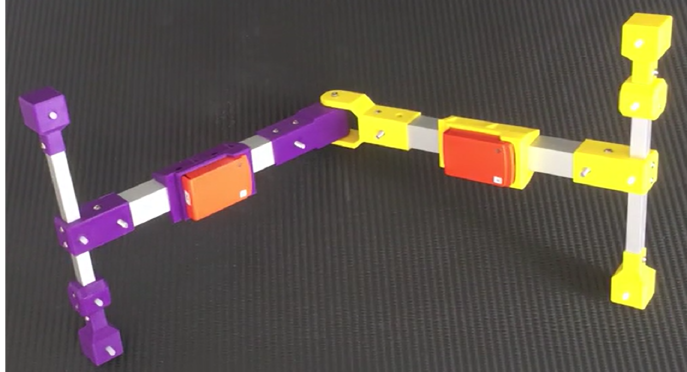
Figure 3. The 3D printed hinge joint system, design by Dustin Lehmann, with the two IMUs (orange boxes, 34 × 58mm) attached.